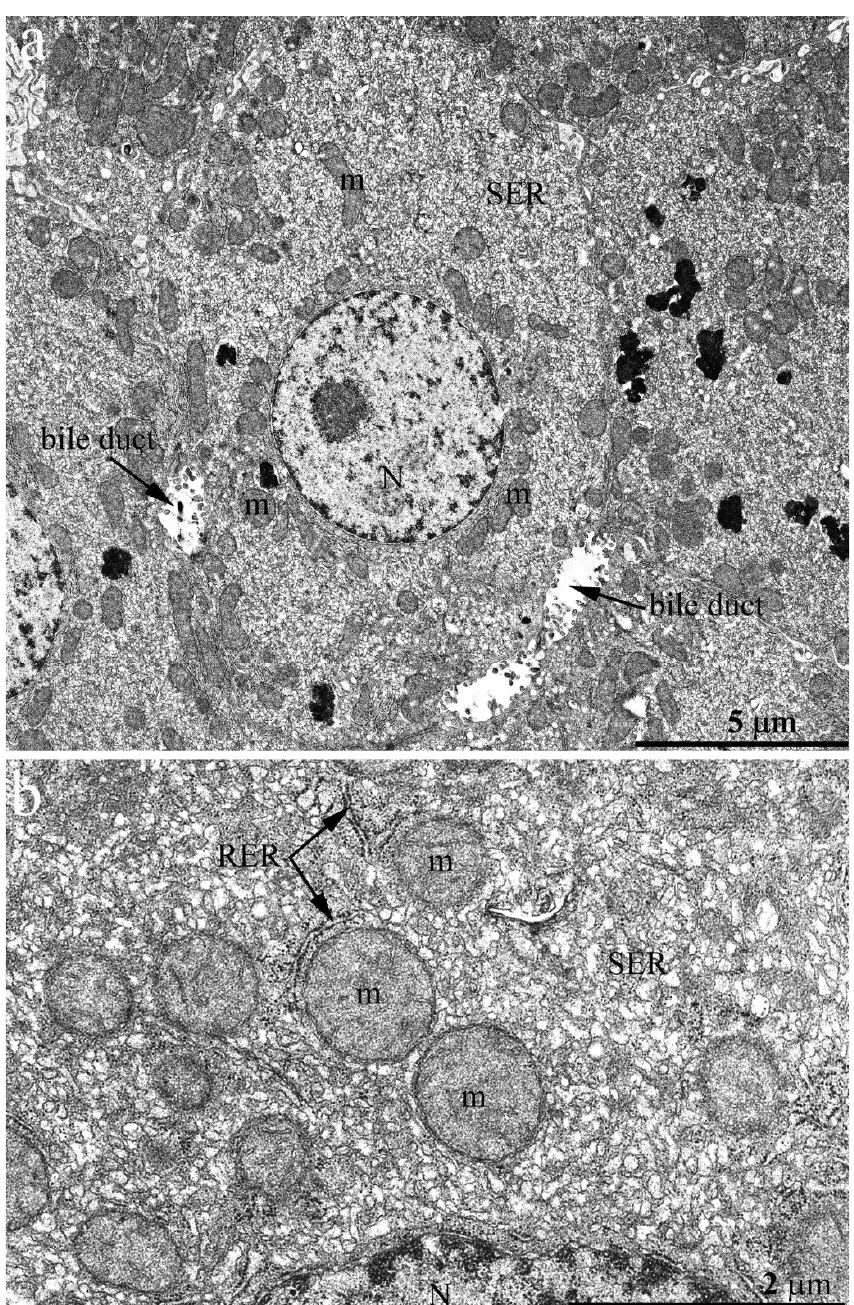
Figure 5. Hepatocyte ultrastructure of H. glaber aged 7 years. ( a ) Overview photograph. SER mem- branes tightly fill the cell volume. The area occupied by RER membranes is decreasing; ( b ) Features of the hepatocyte internal ultrastructure. There are no stacks of RER membranes—single cisterns are located between mitochondria (m). The entire internal space of the cells is filled with SER mem- branes.